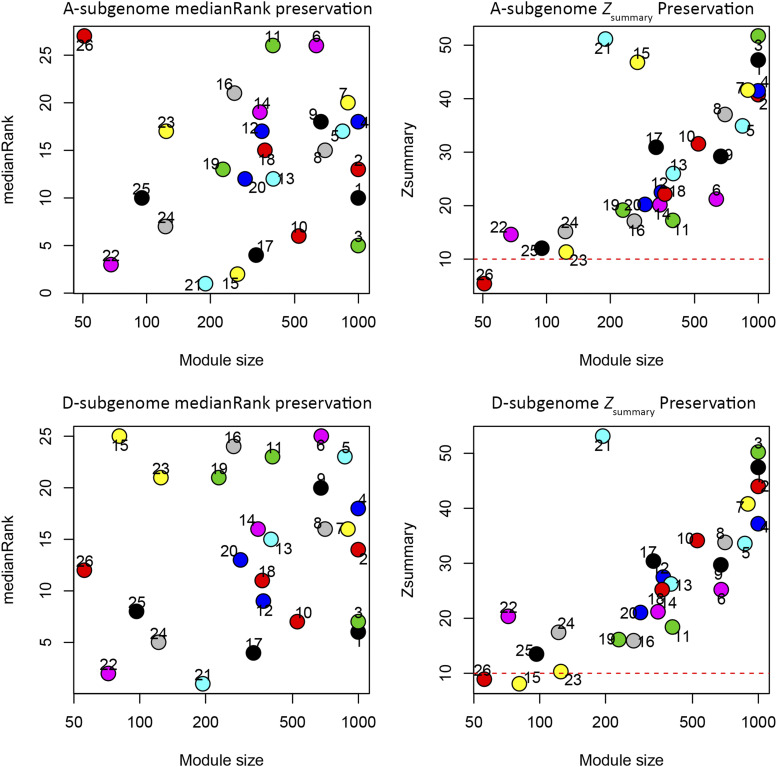
Module preservation of joint gene coexpression network topology in A- and D-subgenomes. The top two graphs show joint module preservation in the A-subgenome fiber expression data, while the bottom two graphs show the joint module preservation in the D-subgenome fiber expression data. Module numbers are shown on graphs; the same numbers correspond to the same joint modules. Red dashed line marks the preservation threshold at Zsummary = 10. For medianRank, a lower score indicates higher preservation relative to higher scores.